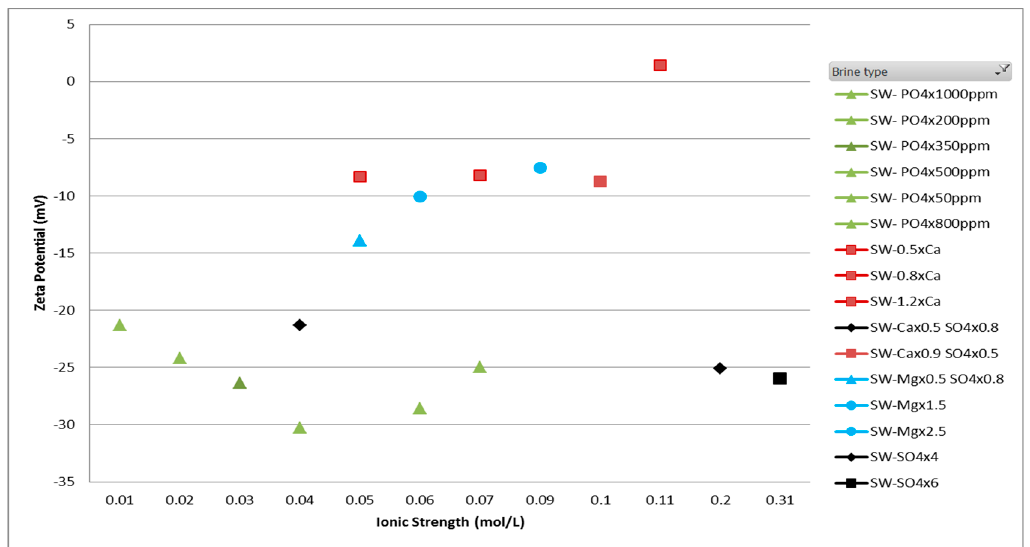
Figure 5. Zeta potential results of smart brines with ionic strength to show the effect of PDIs—SO 42 − , Ca 2+ and Mg 2+ . Trend lines with arrows indicate the zeta potential trend with increasing concentration of each ion.